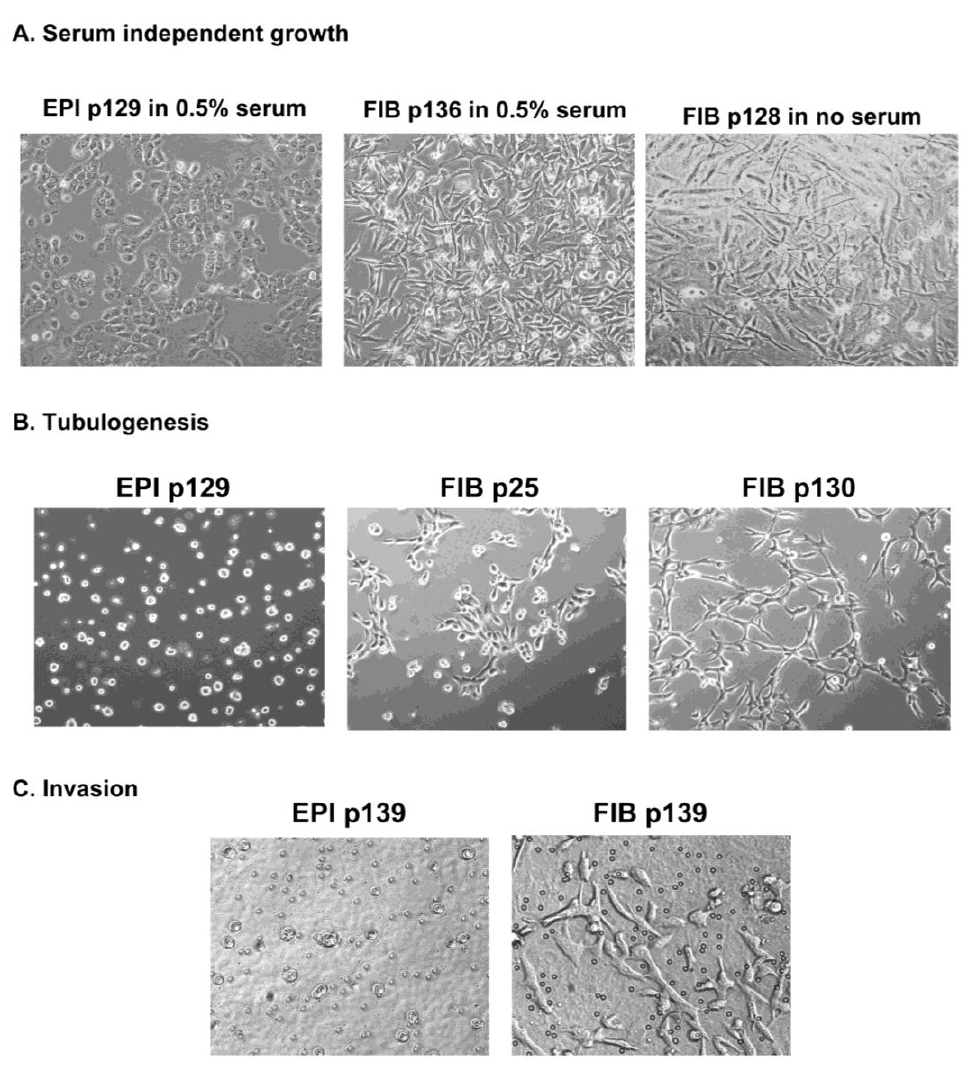
FIGURE 3. Transformation characteristics of FIB cells compared with EPI cells. (A) FIB cells exhibited serum- independent growth better than EPI cells. FIB cells were more proliferative in low and no serum cultures. FIB cells became even more spindle shaped when cultured in no serum. (B) Formation of tubulogenic morphogenesis of FIB cells on Matrigel. EPI and FIB cells at p 129–130 were plated on prepared Matrigel-coated dishes for 4 days in DMEM containing 1% FCS. FIB cells formed tubules (cords without lumen) with extensive meshwork. (C) By using Boyden chamber assay, FIB cells invaded through filters better than EPI